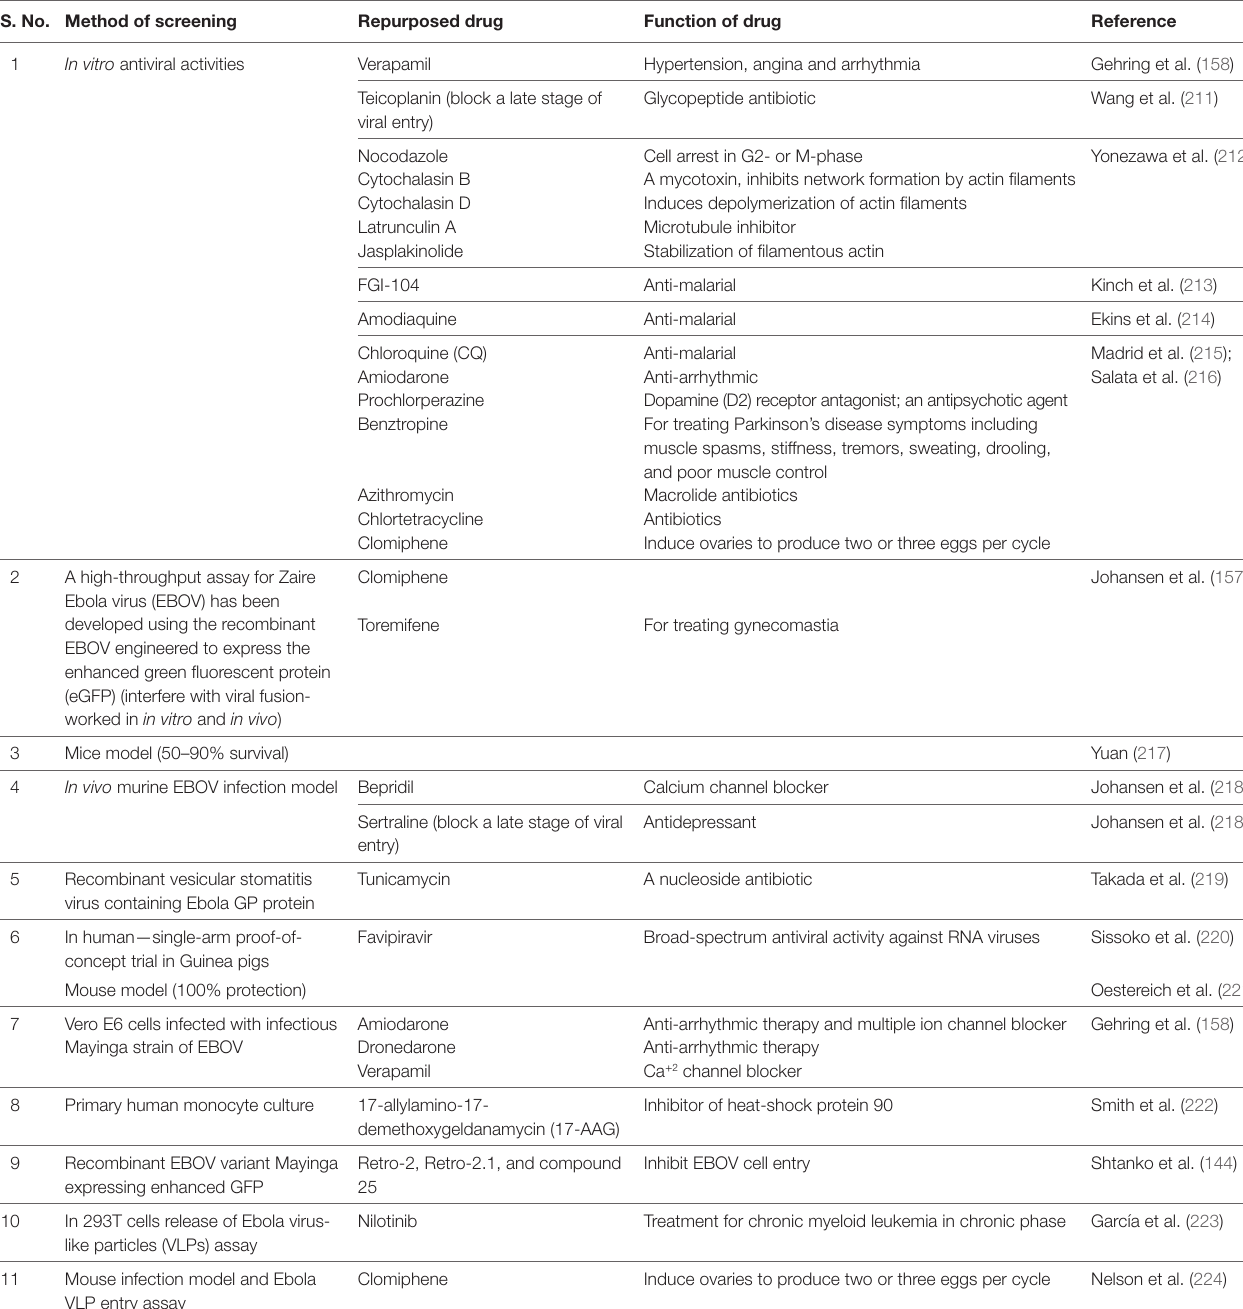
TABLe 2 | Repurposed drugs used in Ebola virus disease